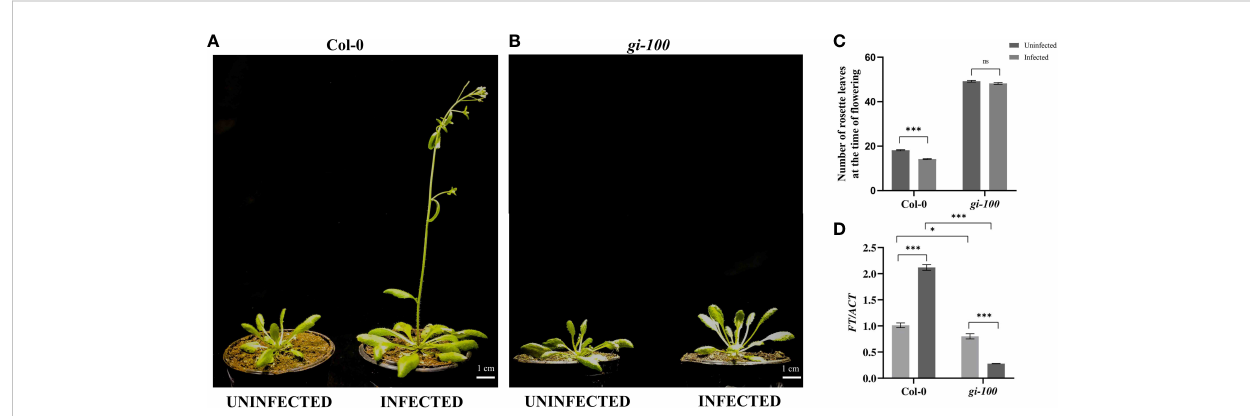
FIGURE 3 Analysis of fl owering time phenotype in the F. oxysporum -infected Col-0 plants (A) Phenotype of 29-day mature Col-0 and (B) gi-100 plants that were infected with F. oxysporum (9 DPI) and uninfected plant as control. (C) Number of rosette leaves in Col-0 and gi-100 at the time of fl owering. (D) Transcript expression analysis of FT gene using RT-qPCR after 24 HPI in Col-0 and gi-100 . ACTIN was used to normalize transcript levels. The qRT-PCR reactions were done in triplicate from three biological replicates. Two-way analysis of variance (ANOVA) using Tukey ’ s multiple comparisons test was performed with the help of GraphPad Prism to test for signi fi cance among the dataset, * p < 0.05, **** p < 0.001. ns, Non-signi fi